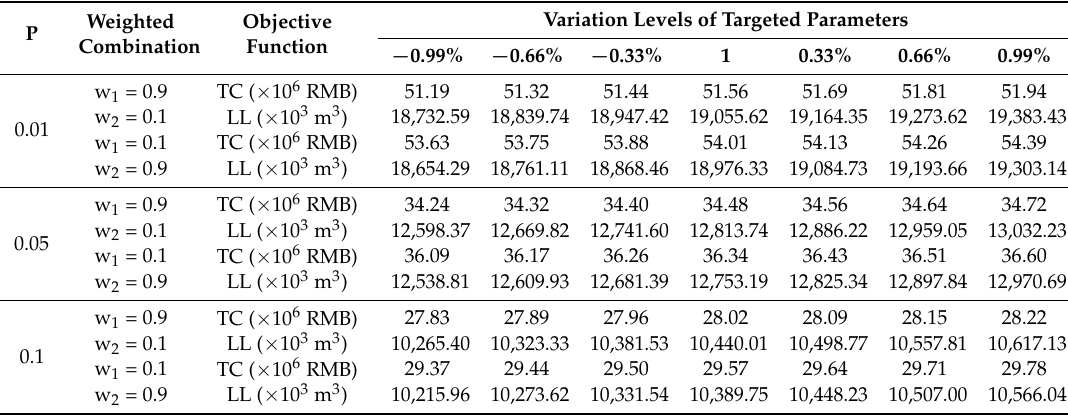
Table 7. The demonstration of leakage rate variation affecting the model